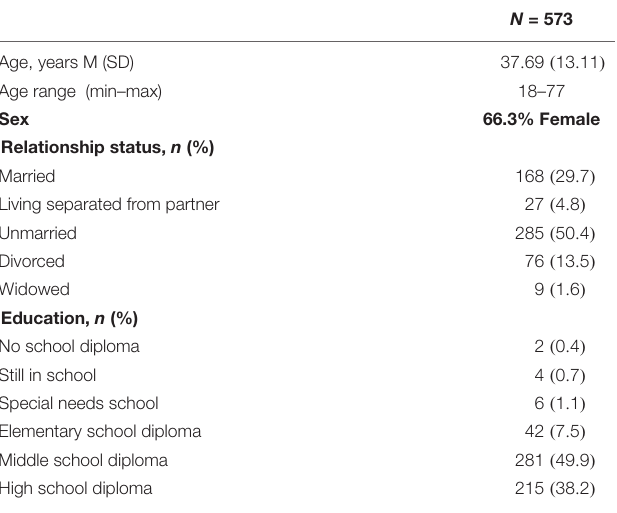
TABLE 1 | Socio demographic variables of the